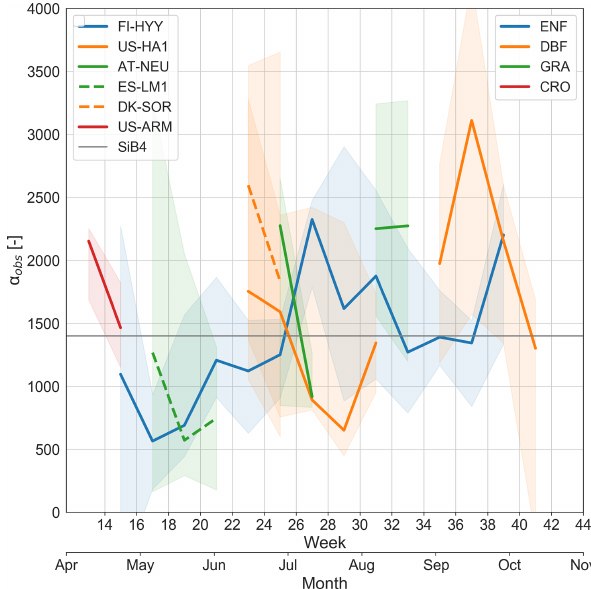
Figure 4. Seasonal change in (2-weekly) median observation-based calibration factor α ( α obs ; see Eq. 10) per site in which colors are separated by PFT. The shaded areas represent the 25th–75th per-